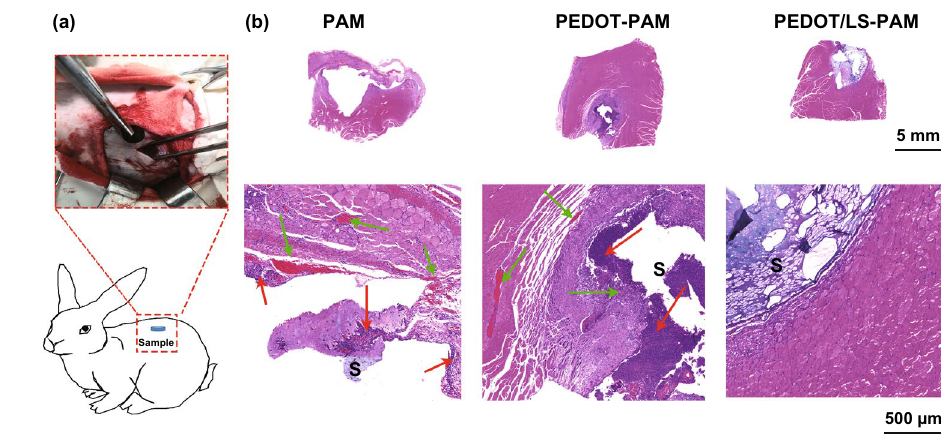
Fig. 9 a Surgical operation of the hydrogel implanted in subcutaneous muscle space of New Zealand white rabbit for biocompatibility evalu- ation. b Representative photomicrographs of hematoxylin and eosin (H&E) stained surrounding tissues after 14 days of implantation. Green arrows indicate eosinophils; red arrows indicate macrophages; S means